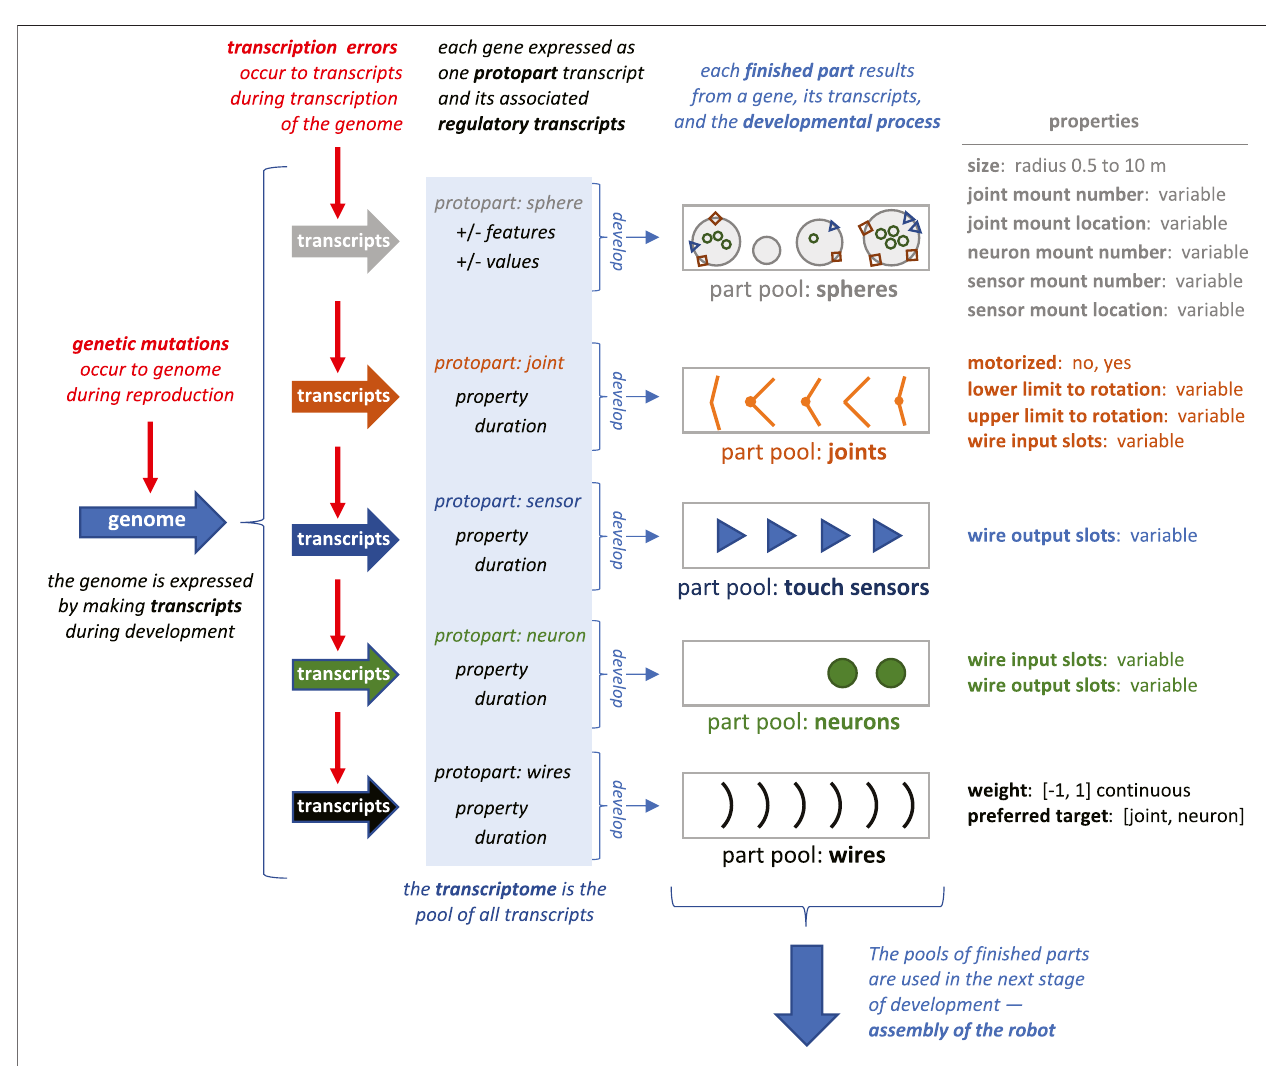
FIGURE2| Transcriptionerrorsandtheirimpactonearlydevelopment.Eachgeneisexpressedonceduringdevelopment,makingonetranscriptthatisaprotopart and multiple transcripts that encode the part ’ s properties and developmental duration. The protopart develops into a fi nished part by having property transcripts add to orsubtractfromthegrowingpart ’ spropertiesincrementallyovertime.Thedurationoftheprocess — andthustheextentoftheincrementaleffects — isdeterminedbythe magnitude regulatoryelements (see Figure 1 ).Asparts are fi nished, they are addedin sequence to theindividual ’ s part pool. Early developmentiscomplete when alltheexpressedprotopartshavebeenturnedinto fi nishedparts.Shapesofpartsasrepresentedherearesimpli fi cationsofthe3Dshapessimulated.Notallpropertiesof the parts are represented